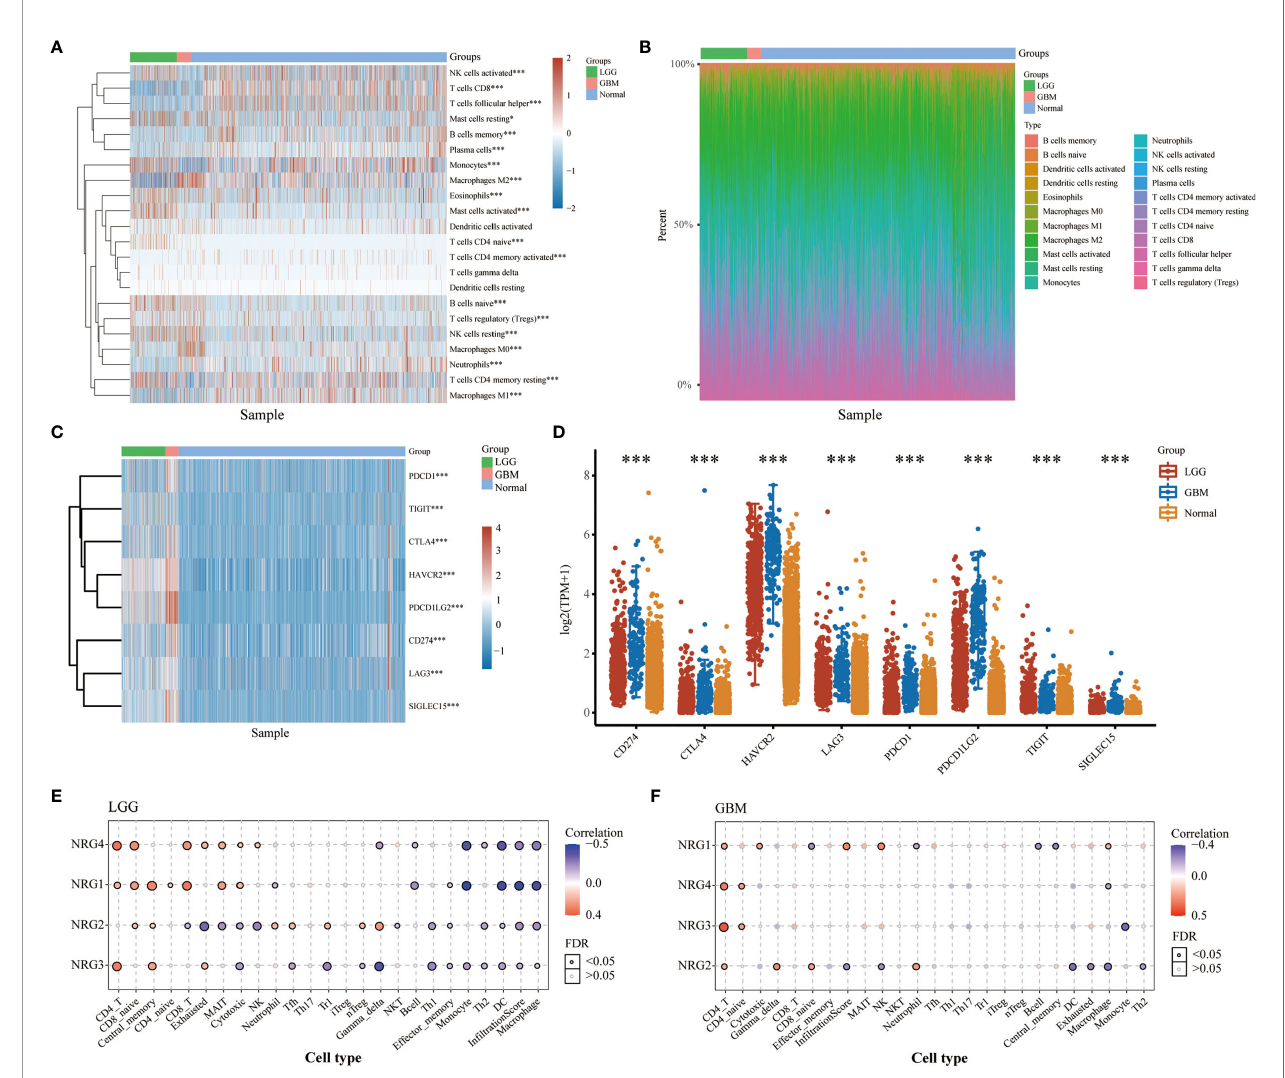
FIGURE 2 | Landscape of the TME in LGG and GBM. The score heatmap of 22 immune cells in LGG and GBM, where different colors represent the expression trend in different samples (A) (LGG: n=510, GBM: n=153, Normal: n=5). The percentage abundance of tumor-in fi ltrating immune cells in each sample, with different colors representing different types of immune cells (B) . The abscissa represents the samples, and the ordinate represents the percentage of immune cell content in a single sample. The expression heatmap (C) and distribution (D) of immune checkpoints-related genes in LGG and GBM, where different colors represent the expression trend in different samples (LGG: n=510, GBM: n=153, Normal: n=2647). Correlation between NRG1-4 expression and immune in fi ltrates in both LGG (E) and GBM (F) . The signi fi cance of the different groups of samples passed the Kruskal-Wallis test. *P < 0.05; ***P <